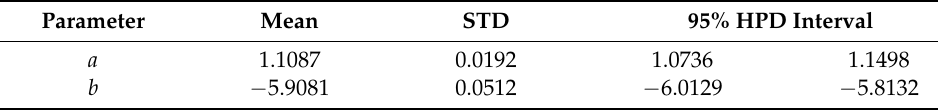
Table 5. Parameters calculated without the Bayesian